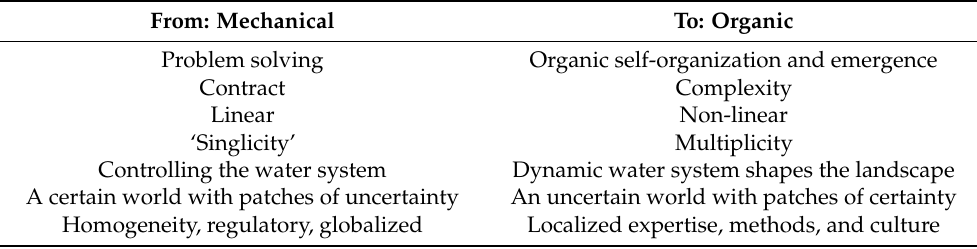
Table 1. Shift from mechanical to organic worldview. From: Mechanical To: Organic Problem solving Contract